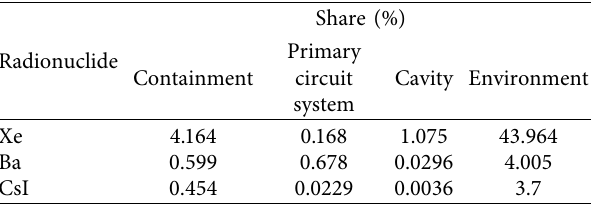
Table 4: Distribution of radionuclide release share of fully exposed core.